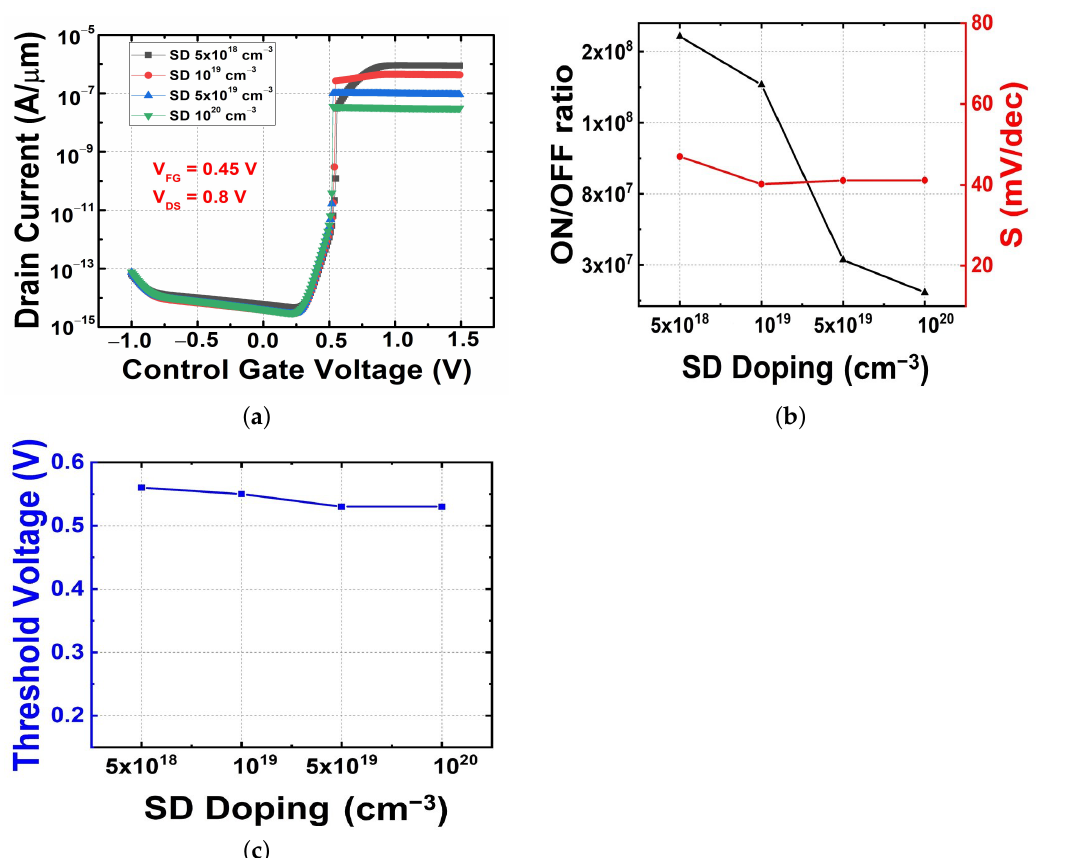
Figure 4. Electrical characteristics obtained with source drain doping variations. ( a ) Transfer charac- teristics, ( b ) on–off current ratio and subthreshold swing, and ( c ) threshold